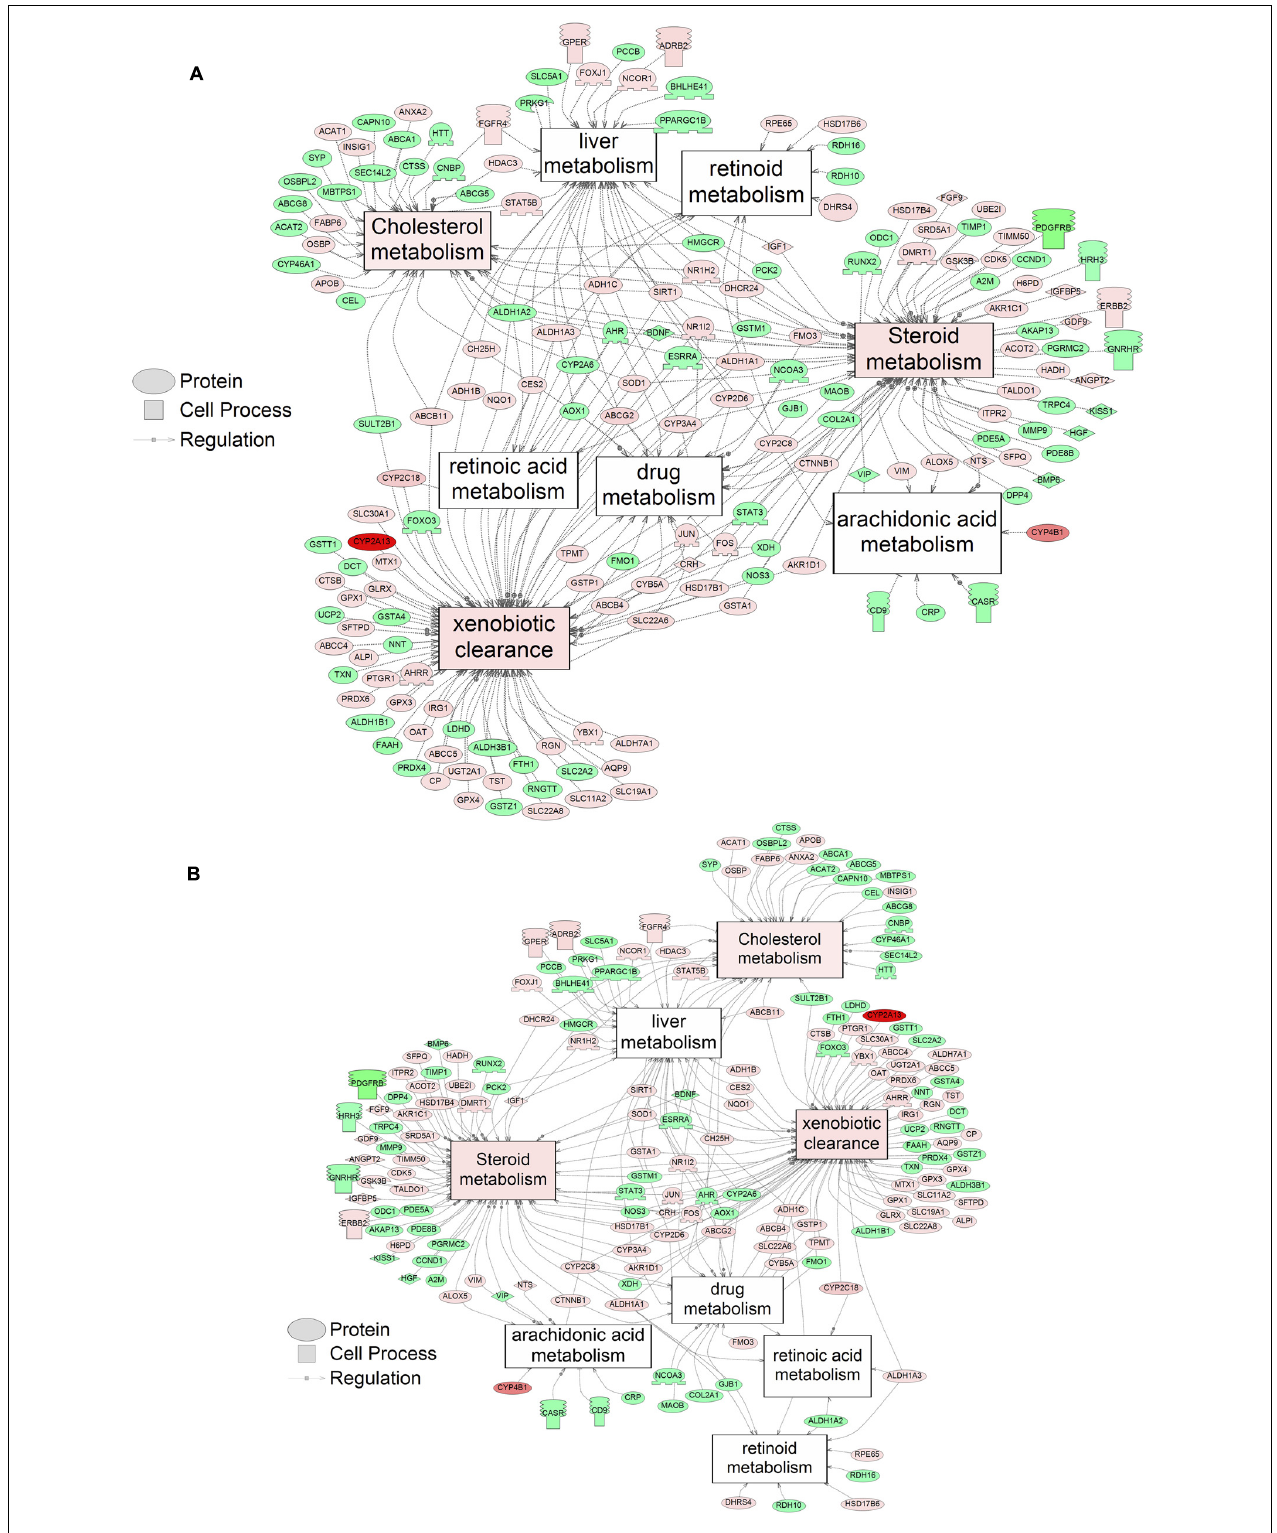
FIGURE 2 | Networks associated with metabolism indicating altered gene regulation following exposure of S. tropicalis to 2 mg/L of S1 (A) and S2 (B) . Sub-network enrichment analysis (SNEA) was performed using Pathway Studio 9.0. Pink and red indicate that the transcript abundance was increased and green indicates that the transcript abundance was decreased ( p < 0.05). The abbreviations are the official gene symbol of the transcripts of the respective pathway ( Supplementary Tables S6, S7 ).